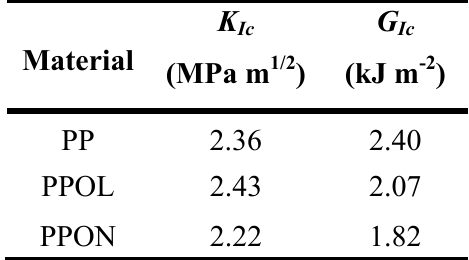
Table 5. Fracture parameters for PP/AL(OH) and ON particles is 1.5 and 60 μ m respectively. Data extracted from